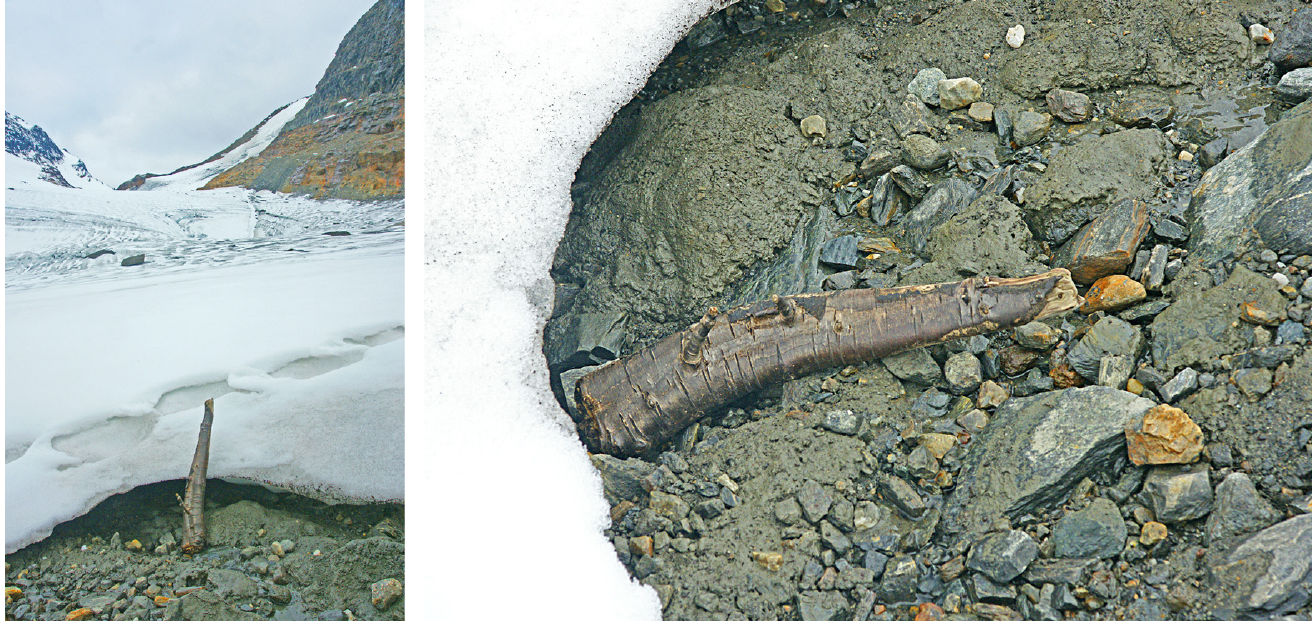
Figure 23: Kårsajökeln (8). Basal birch trunk with intact bark and remnants of twigs, exposed close to the glacier front. 8710 cal. yr BP (Beta-250917).